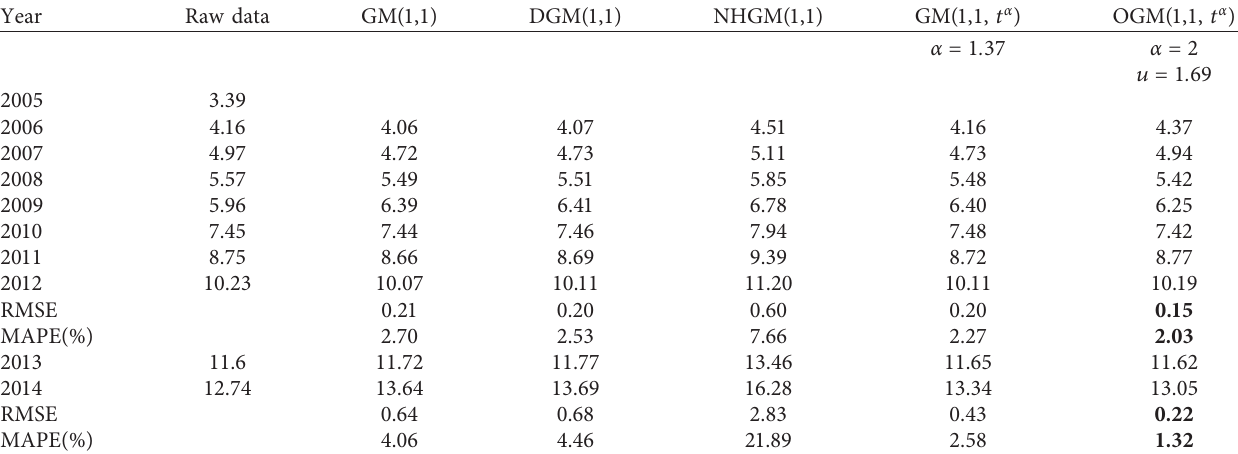
Table 1: The simulated results and indices by five grey models.